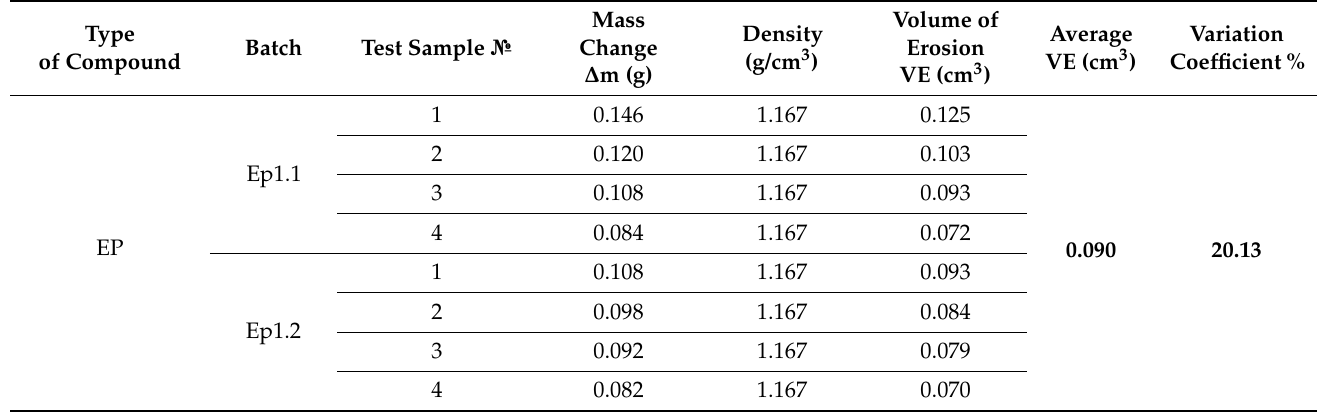
Table A1. Wear of unfilled epoxy binder (EP) at 23 ◦ C at an impingement angle of 90 ◦